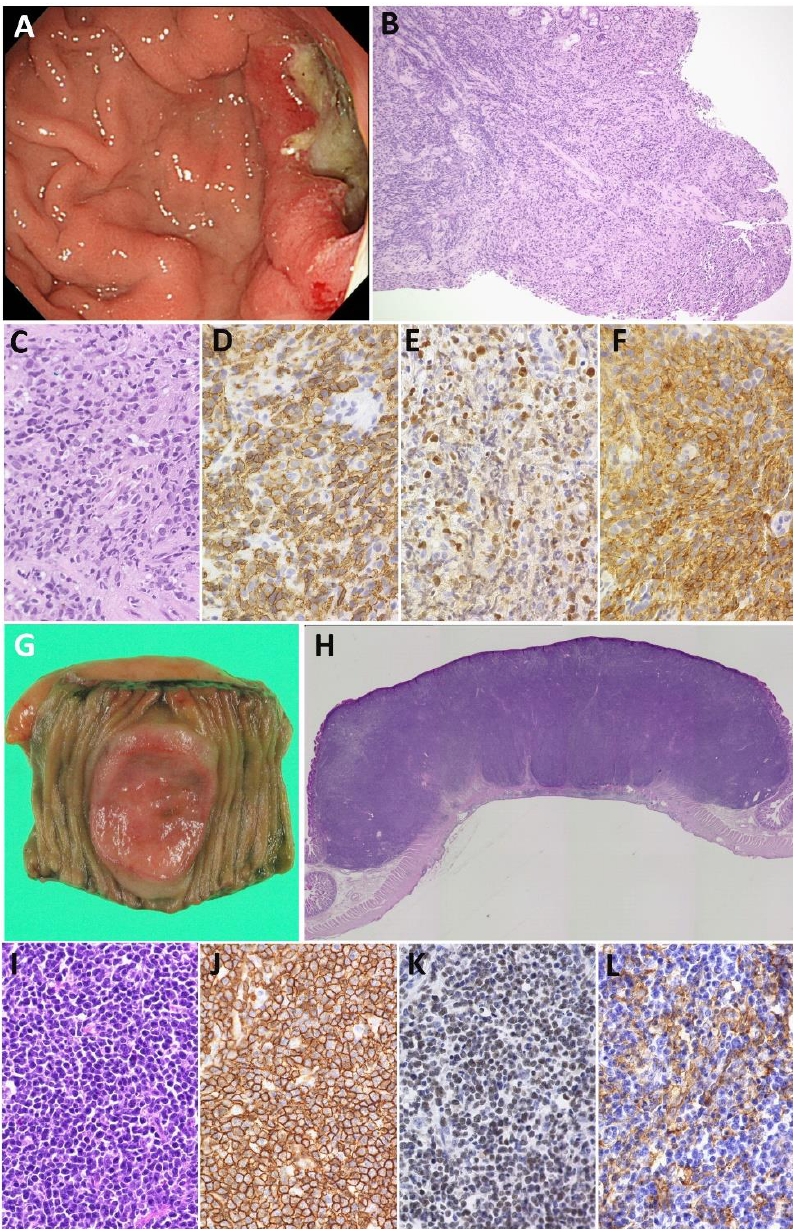
Figure 2. Comparison of PD-L1 expression on tumor cells and nonmalignant immune cells. ( A – F ) EBV + gDLBCL with PD-L1 expression on tumor cells. ( A ) Endoscopic image showing an ulcerated mass in the antrum of the stomach. ( B , C ) Biopsy specimen revealed diffuse lymphoid proliferation of medium to large cells. ( D ) The tumor cells were positive for CD20, ( E ) EBER, and ( F ) PD-L1. ( G – L ) EBV + iDLBCL with PD-L1 expression on microenvironment immune cells. ( G ) Surgically resected specimen has an ulcerated mass in the jejunum. ( H ) Well circumscribed tumor mass with invasion of the muscularis propria. ( I ) Diffuse proliferation of mononuclear cells. ( J ) The tumor cells were strongly and uniformly positive for CD20 and ( K ) EBER. ( L ) PD-L1 expression was detected in im- mune cells, but not in tumor cells. Original magnifications: ×100 (B) and ×200 ( C – F , I – L )